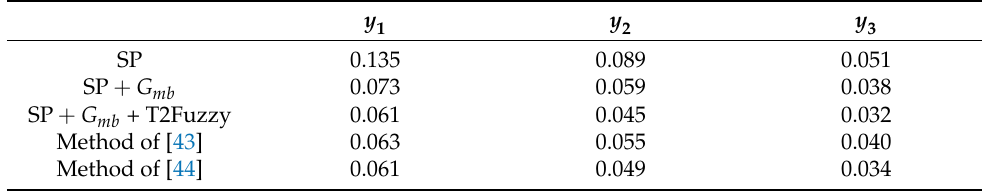
Table 1. A comparison between some methods for example